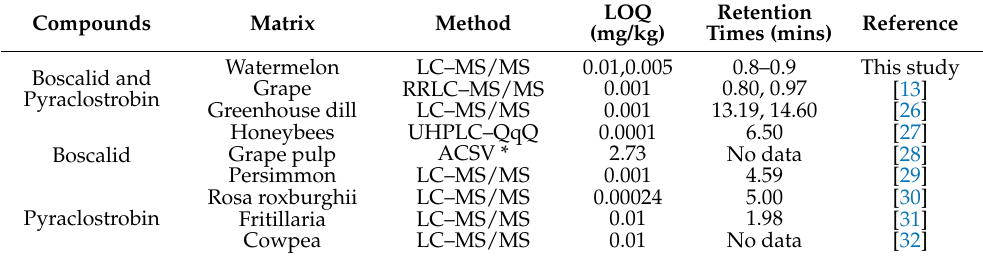
Table 2. Comparison of detection methods of boscalid and pyraclostrobin in different matrices.